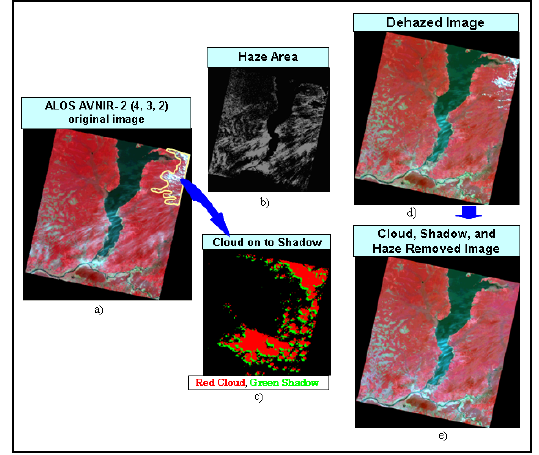
Figure 4. ALOS AVNIR-2 Cloud/Shadow & Haze Removal a) ALOS AVNIR-2 with Cloud/Shadow & Haze b) Haze Area c) Cloud on to Shadow d) Dehazed